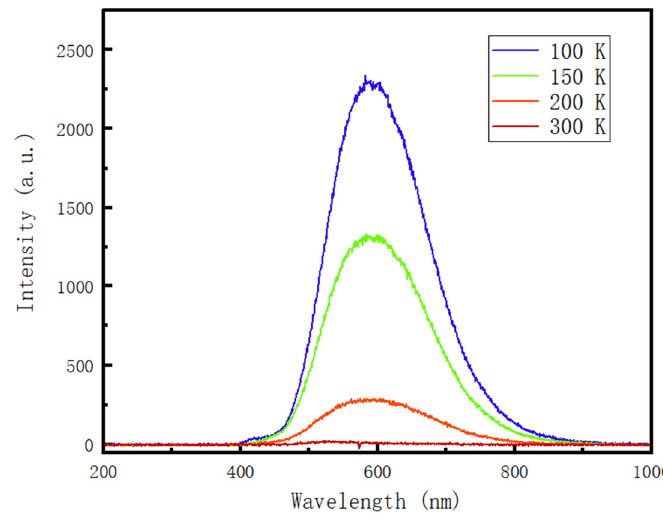
Figure 9. Measurement results of samples annealed at 900 °C at the fluence of 1.45 × 10 11 ions/cm 2 at different